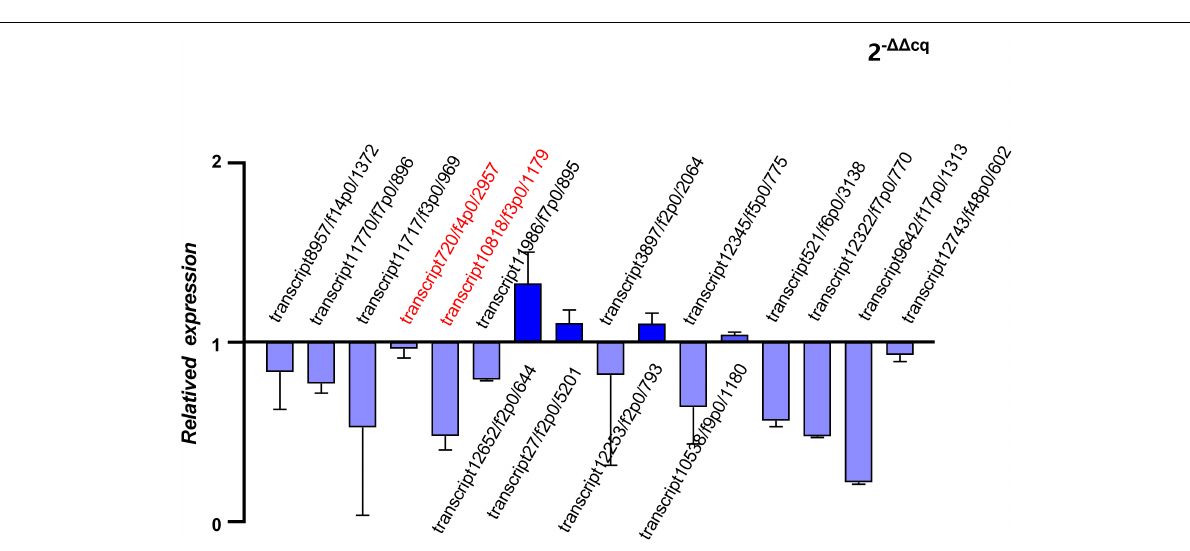
Frontiers in Microbiology |